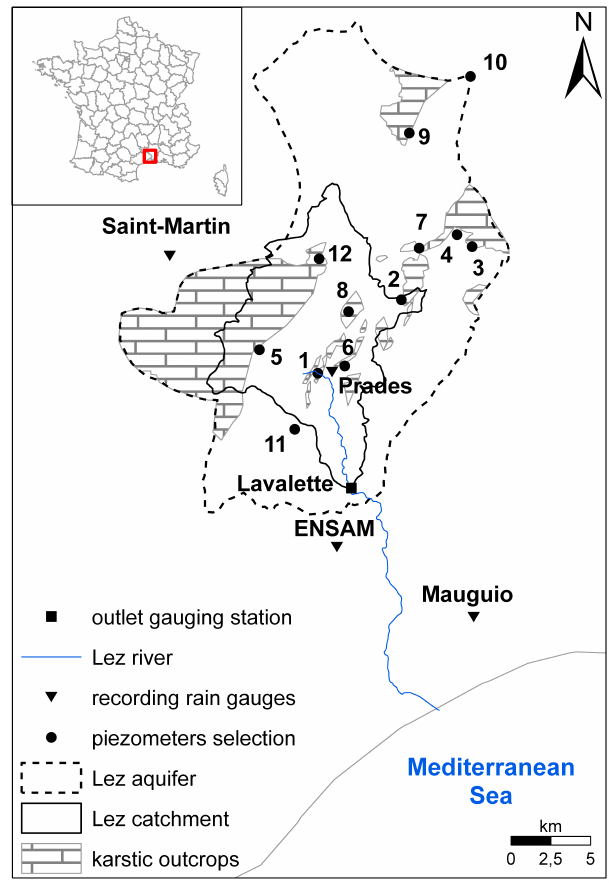
Fig. 3. Location of the Lez Figure 3: Location of the Lez basin 3